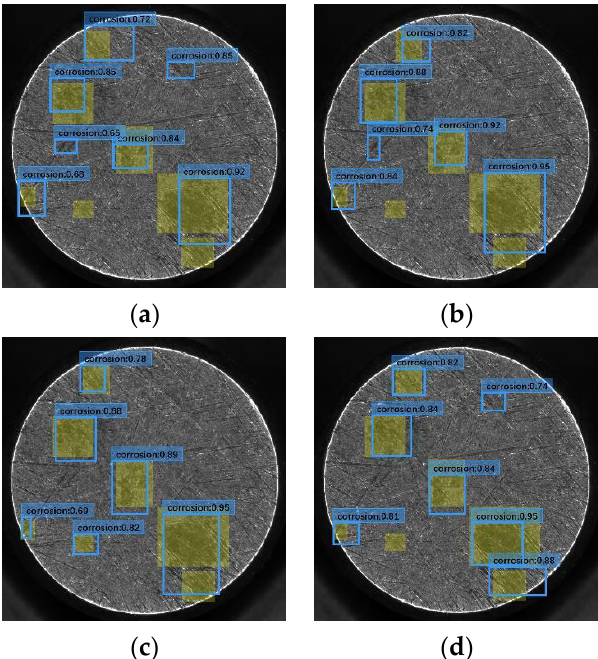
Figure 10. Detection results under different α : ( a ) α = 0.8; ( b ) α = 0.9; ( c ) α = 1.05; and ( d ) α = 1.2.